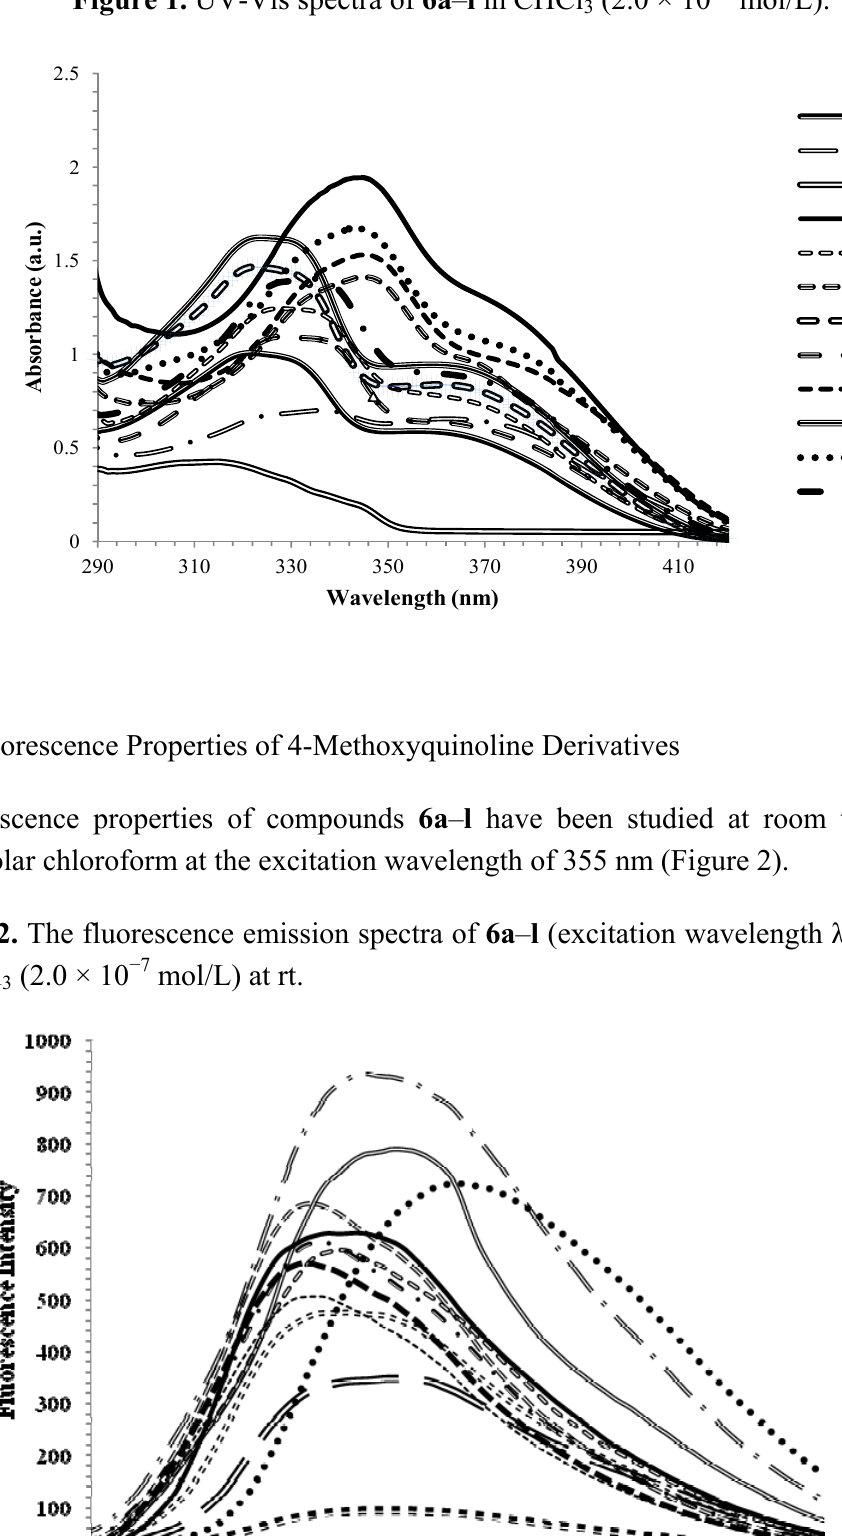
Figure 1. UV-Vis spectra of 6a – l in CHCl